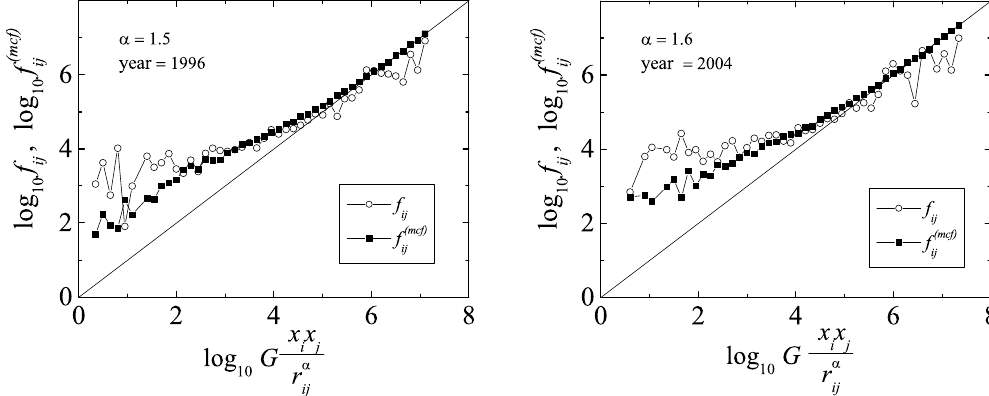
Figure 3. Performance of the model of connected flights (black squares) against real data (open circles) for two years: 1996 and 2004. Straight lines correspond to the standard gravity